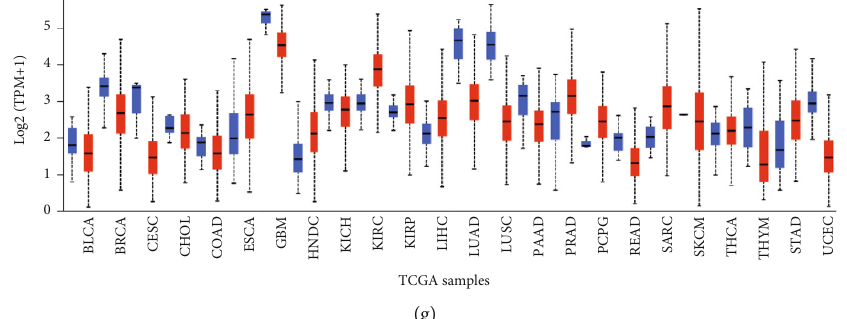
Figure 3: The survival analysis of DOCK4 in various cancers and expression patterns of DOCK4 across TCGA cancer types. (a – e) Kaplan-Meier curves show the correlation between DOCK4 expression and overall survival of SARC, STAD, UCEC, KIRC, and HNSC patients, respectively. (f) The summary of the expression pattern of DOCK4 across 33 tumors. ACC: adrenocortical carcinoma; BLCA: bladder urothelial carcinoma; BRCA: breast invasive carcinoma; CESC: cervical squamous cell carcinoma and endocervical adenocarcinoma; CHOL: cholangiocarcinoma; COAD: colon adenocarcinoma; DLBC: lymphoid neoplasm di ff use large B cell lymphoma; ESCA: esophageal carcinoma; GBM: glioblastoma multiforme; HNSC: head and neck squamous cell carcinoma; KICH: kidney chromophobe; KIRC: kidney renal clear cell carcinoma; KIRP: kidney renal papillary cell carcinoma; LGG: brain lower grade glioma; OV: ovarian cancer; MESO: mesothelioma; LIHC: liver hepatocellular carcinoma; LUAD: lung adenocarcinoma; LUSC: lung squamous cell carcinoma; PAAD: pancreatic adenocarcinoma; PCPG: pheochromocytoma and paraganglioma; PRAD: prostate adenocarcinoma; READ: rectum adenocarcinoma; SARC: sarcoma; SKCM: skin cutaneous melanoma; LAML: acute myeloid leukemia; TGCT: testicular germ cell tumors; THCA: thyroid carcinoma; THYM: thymoma; STAD: stomach adenocarcinoma; UCEC: uterine corpus endometrial carcinoma; UCS: uterine carcinosarcoma; UVM: uveal melanoma. (g) The changed expression of DOCK4 in 24 cancer cohorts compared to normal